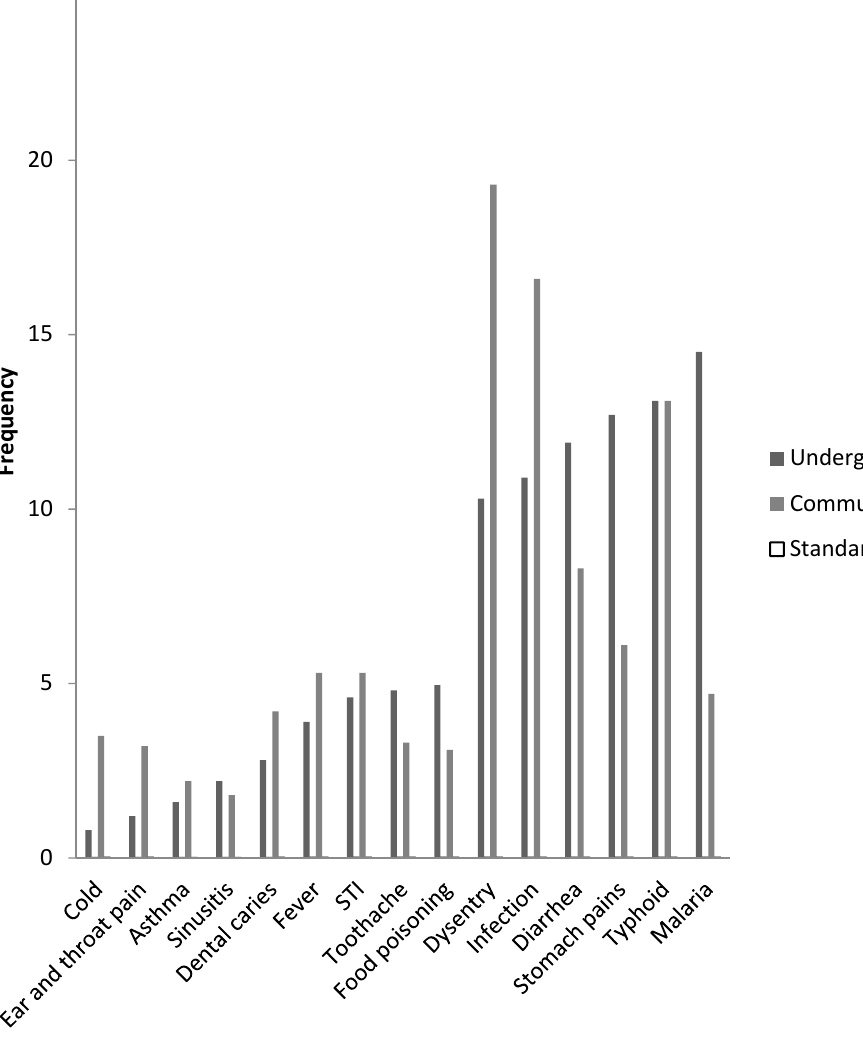
Figure 2. Comparison of commonly treated infections among community members and undergraduate students.